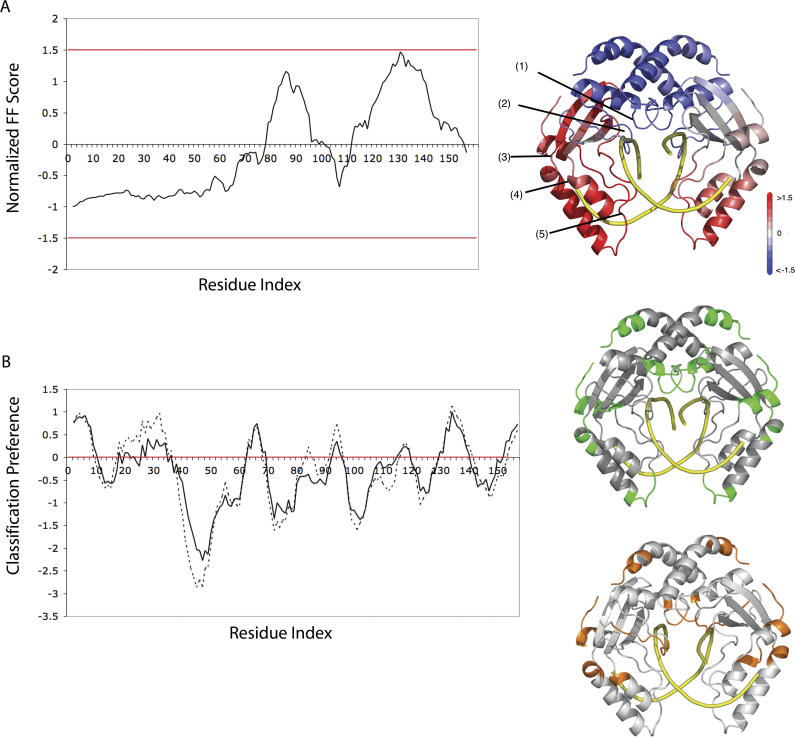
Wiggle Predictors Identify Important FFR in PVUII Endonuclease(A) Plot of FF scores and mapping of values in a gradient code from negative (blue) to positive (red) onto the structure of PVUII endonuclease in complex with DNA (yellow). The following structural features are labeled: (1) minor groove binding loop, (2) catalytic loop, (3) potential hinge for DNA binding, (4) tyrosine 94 for Mg++ ion coordination, and (5) major groove binding loop. (PDB ID: 3PVI).(B) Wiggle predictions (solid line) are mapped in green and Wiggle200 predictions (dashed line) are mapped in orange onto the structure.